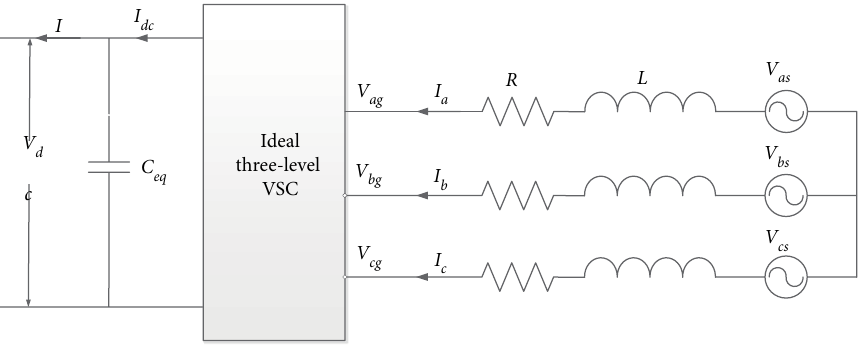
Figure 14: A simplified GSC equivalent circuit.